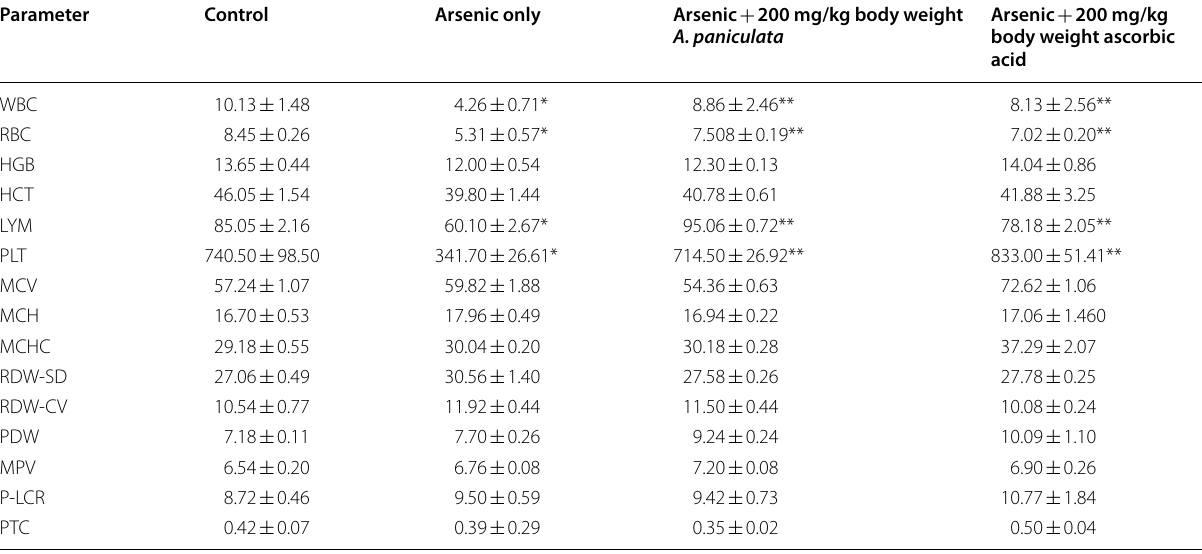
Values are mean SEM ( n 6) ± = * ( p < 0.05) Group 2: (arsenic group rats) compared with group 1: (control rats) **( p < 0.05) Groups 3 and 4: ( A. paniculata or ascorbic acid administered rats, respectively) compared with group 2: (arsenic group rats)